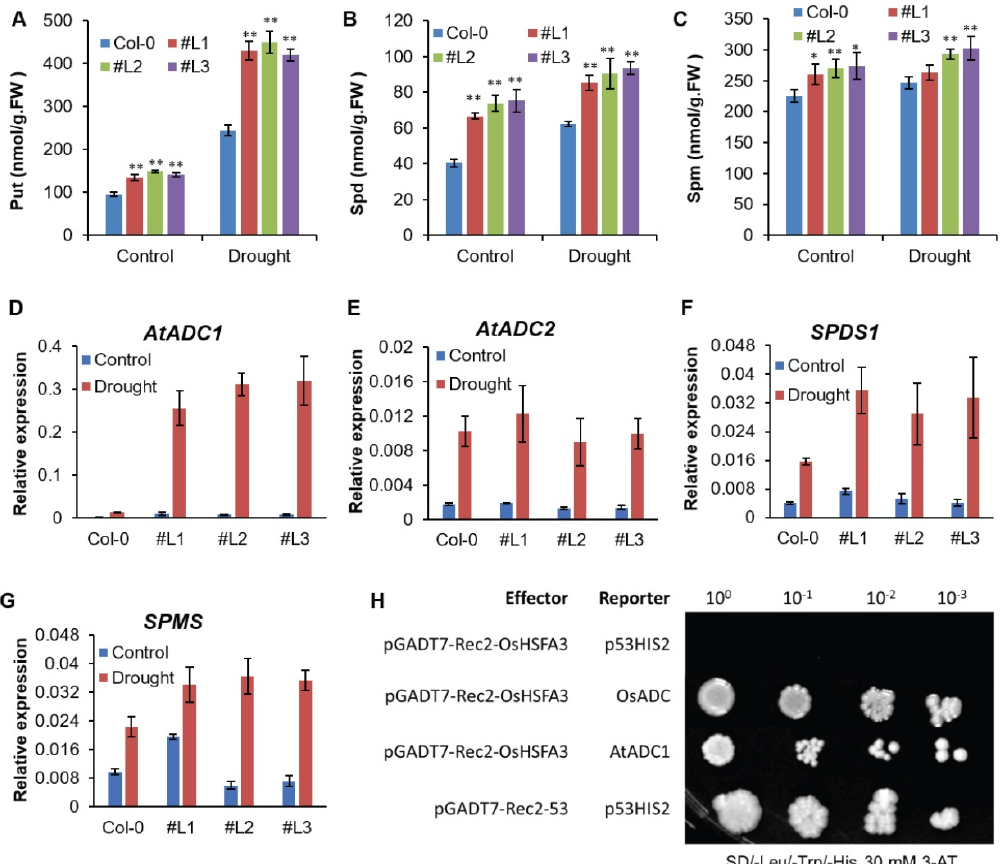
Figure 6. Analysis of polyamines, mRNA abundance and yeast one-hybrid assay for OsHSFA3 . ( A – C ) Free polyamine contents in WT and OsHSFA3- overexpressing transgenic lines before and after drought stress. Put, putrescine; Spd, spermidine; Spm, spermine. Values indicate mean ± SE of 3 biologically independent samples. Significance of data was tested with Student’s t test. * represents p < 0.05, ** represents p < 0.01. ( D – G ) Quantitative real-time PCR analysis of expression levels of stress-responsive genes in WT and OsHSFA3- overexpressing transgenic plants under normal and drought conditions. ( H ) Yeast one-hybrid assay showing that OsHSFA3 can bind to AtADC1 and OsADC in vitro on a triple-dropout